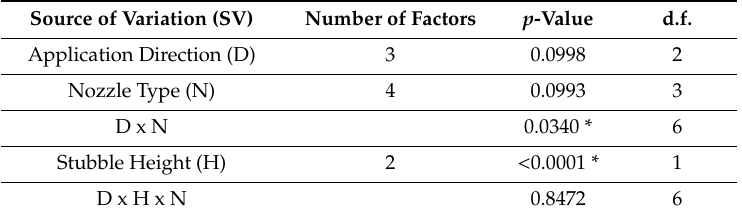
Table 3. ANOVA table and significance of main and interaction e ff ects of application direction, stubble height, and nozzle type on herbicide spray deposition of glyphosate + dicamba tank mixture indicated as relative fluorescence units (RFU).